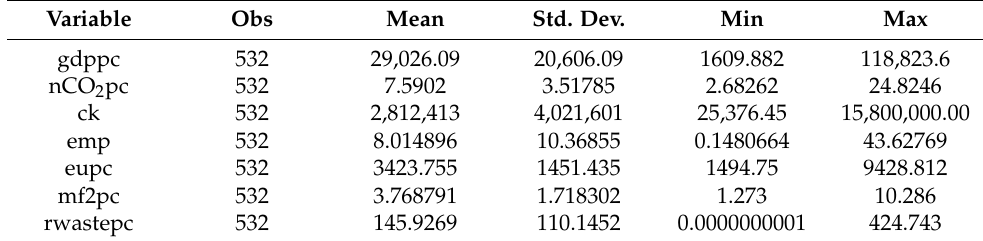
Table 3. Descriptive statistics of variables used in our